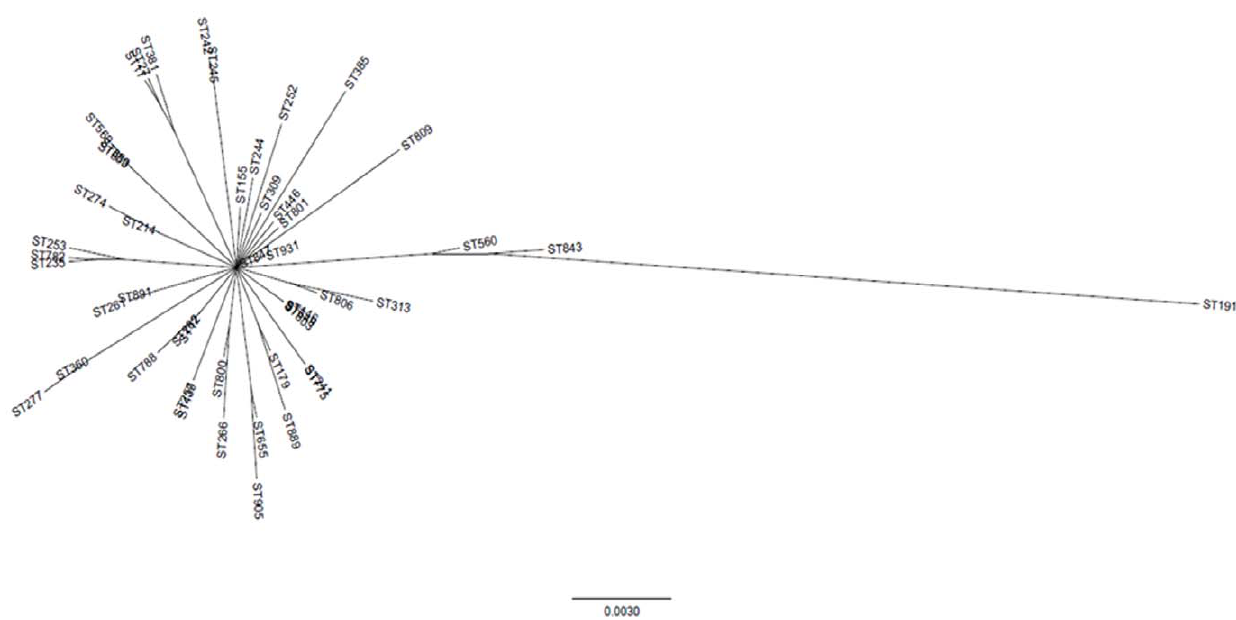
Figure 5. Phylogenetic tree constructed from 48 concatenated guaA, mutL, and nuoD sequences indicating a star-like phylogeny.